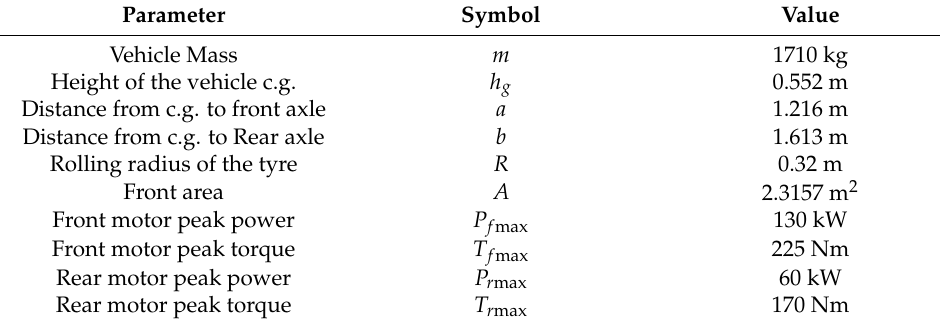
Table 2. Major parameters of the EV. Parameter Symbol Value Vehicle Mass m 1710 kg Height of the vehicle